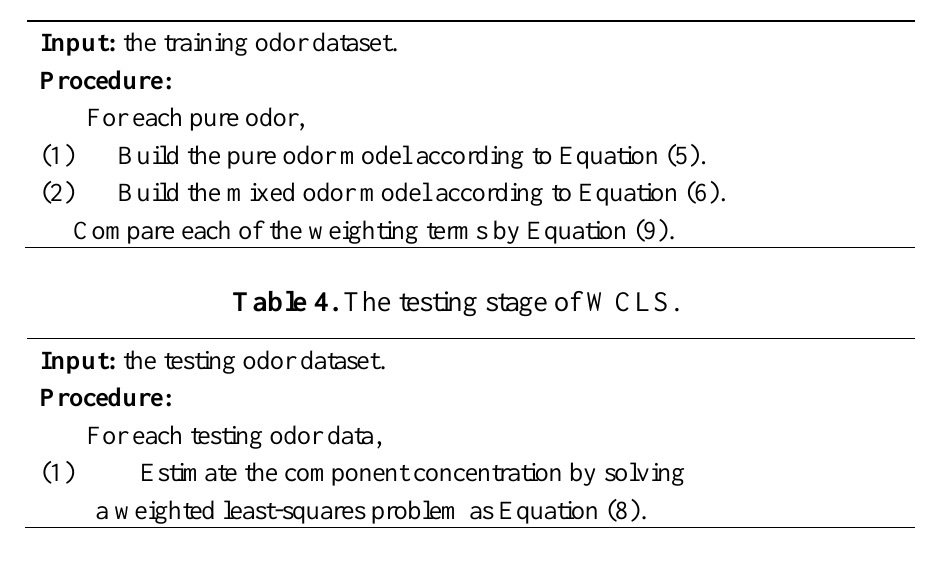
Table 3. The training stage of WCLS.